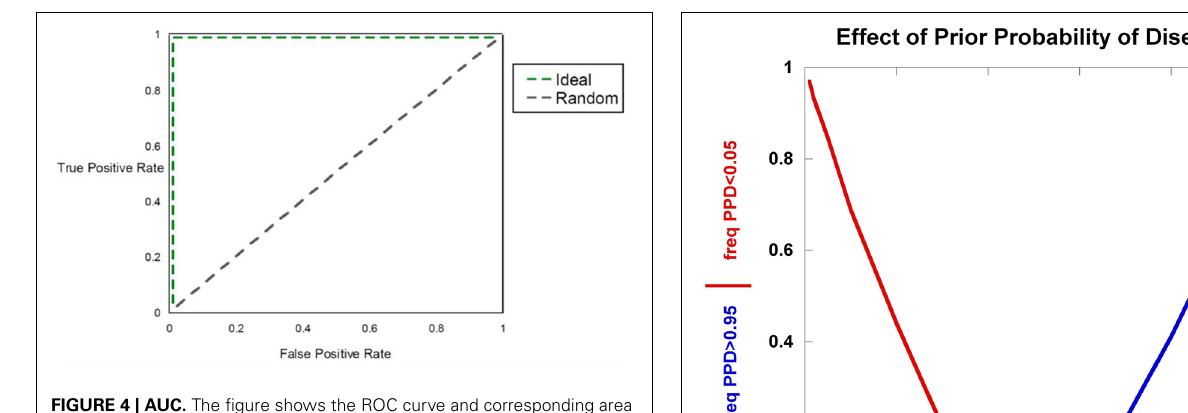
FIGURE 4 | AUC. The figure shows the ROC curve and corresponding area under the ROC curve (AUC). The expected patterns under two extreme scenarios are shown: an ideal diagnostic scenario and the pattern expected using random predictions.